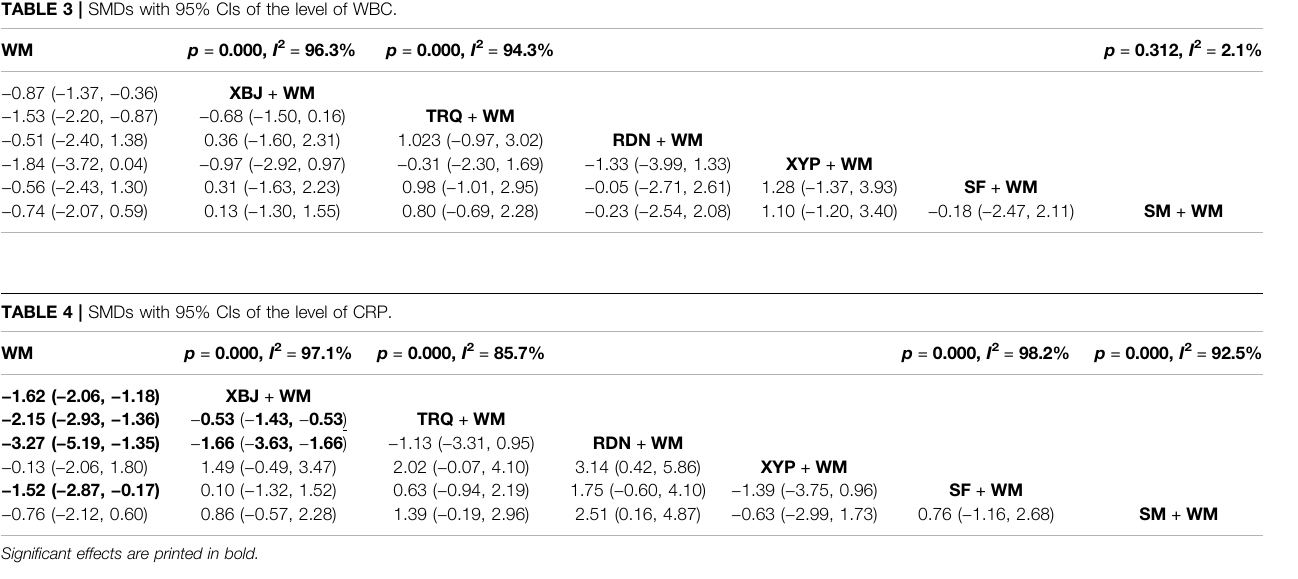
Signi fi cant effects are printed in bold.